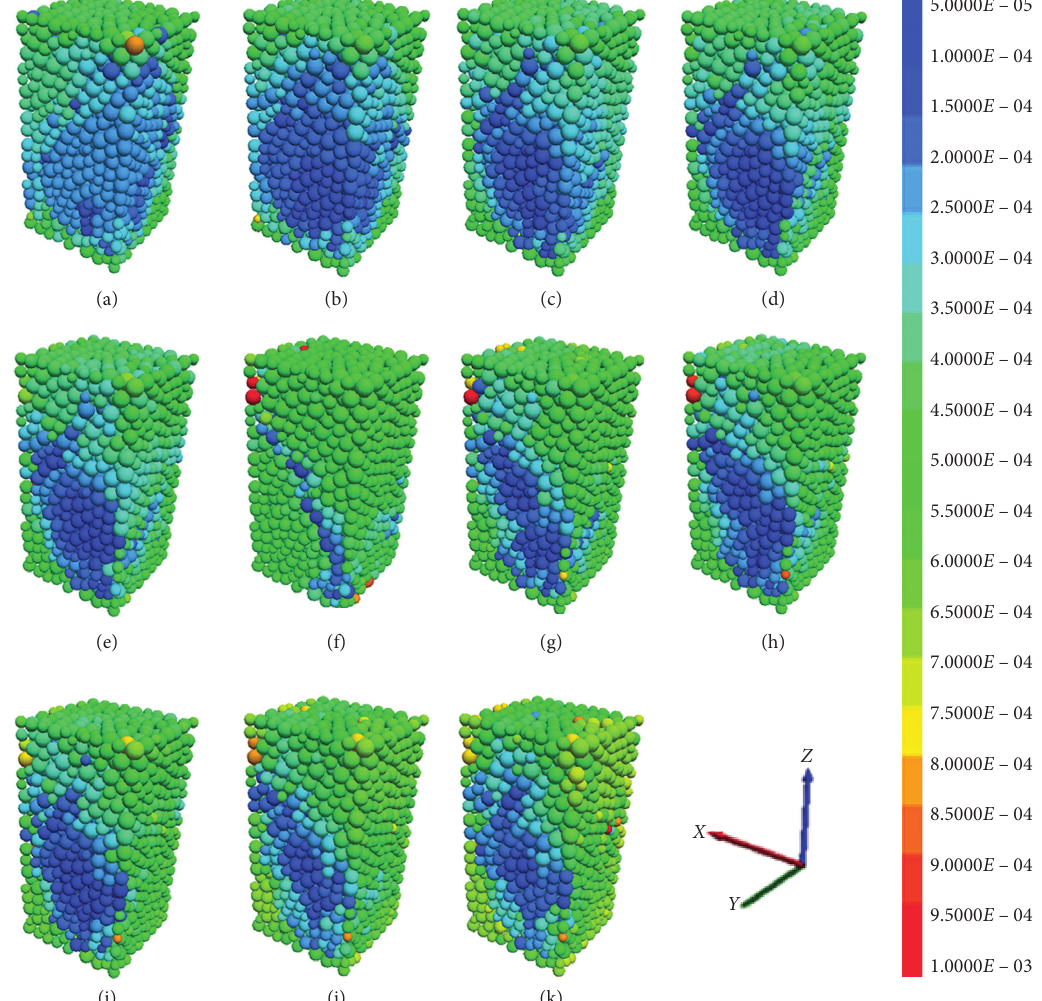
Figure 8: Displacement contours of PFC models. (a) b � 0, (b) b � 0.1, (c) b � 0.2, (d) b � 0.3, (e) b � 0.4, (f) b � 0.5, (g) b � 0.6, (h) b � 0.7, (i) b � 0.8, (j) b � 0.9, and (k) b �